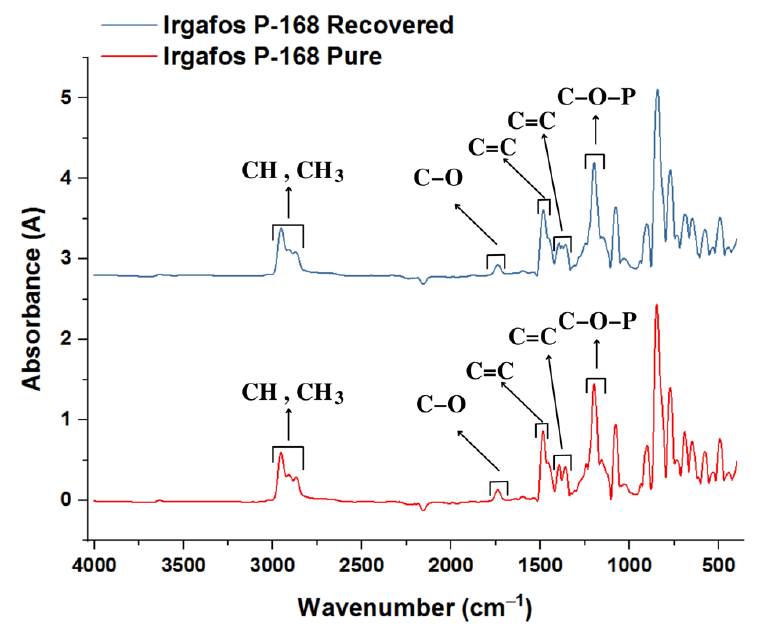
Figure 9. IR spectrogram for pure Irgafos P-168 and IR spectrogram for recovered Irgafos P-168.